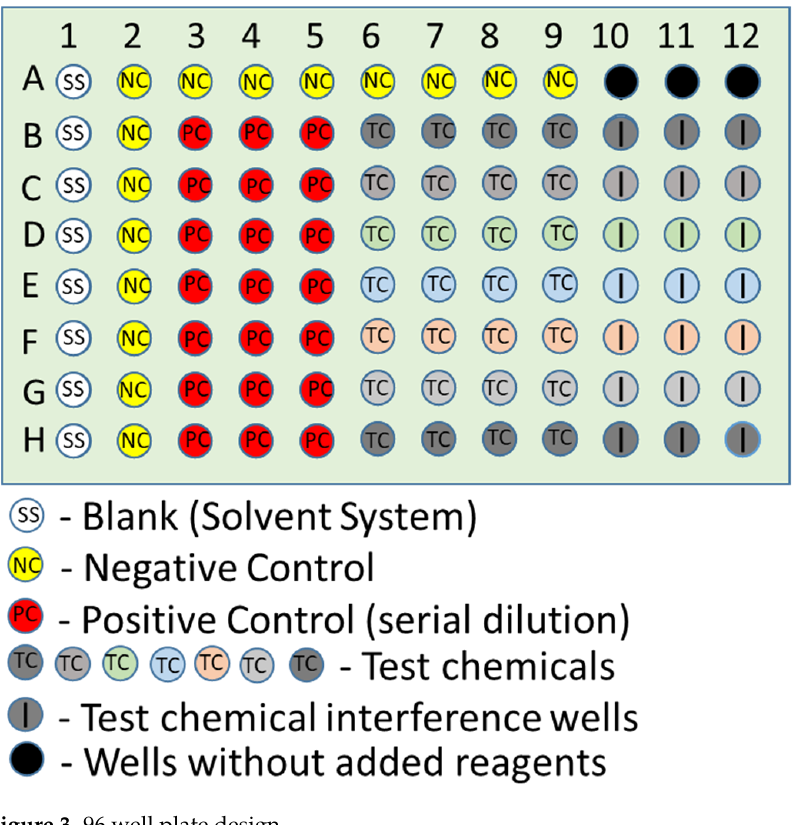
Figure 3. 96 well plate design.